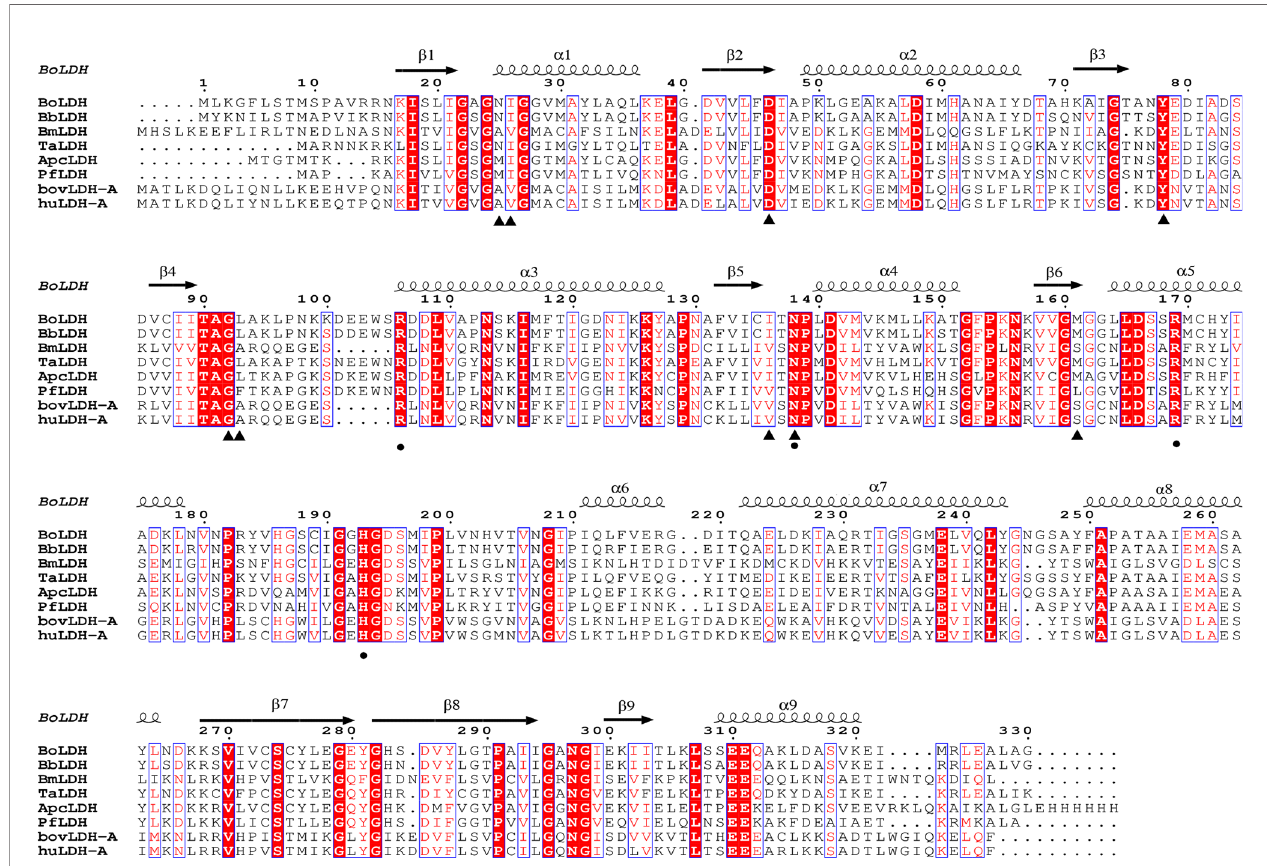
FIGURE 1 | Multiple sequence alignment based on amino acid sequences of BoLDH and related LDHs. BoLDH sequence were aligned with other protozoans and mammals, and the multiple sequence alignment were created by ClustalW. Black triangles indicated the key residues for NADH, and black solid circles indicated the key residues for substrate analog oxamate. The residues were labeled based on the holo PfLDH (PDB accession number 1t2d, Cameron et al.,